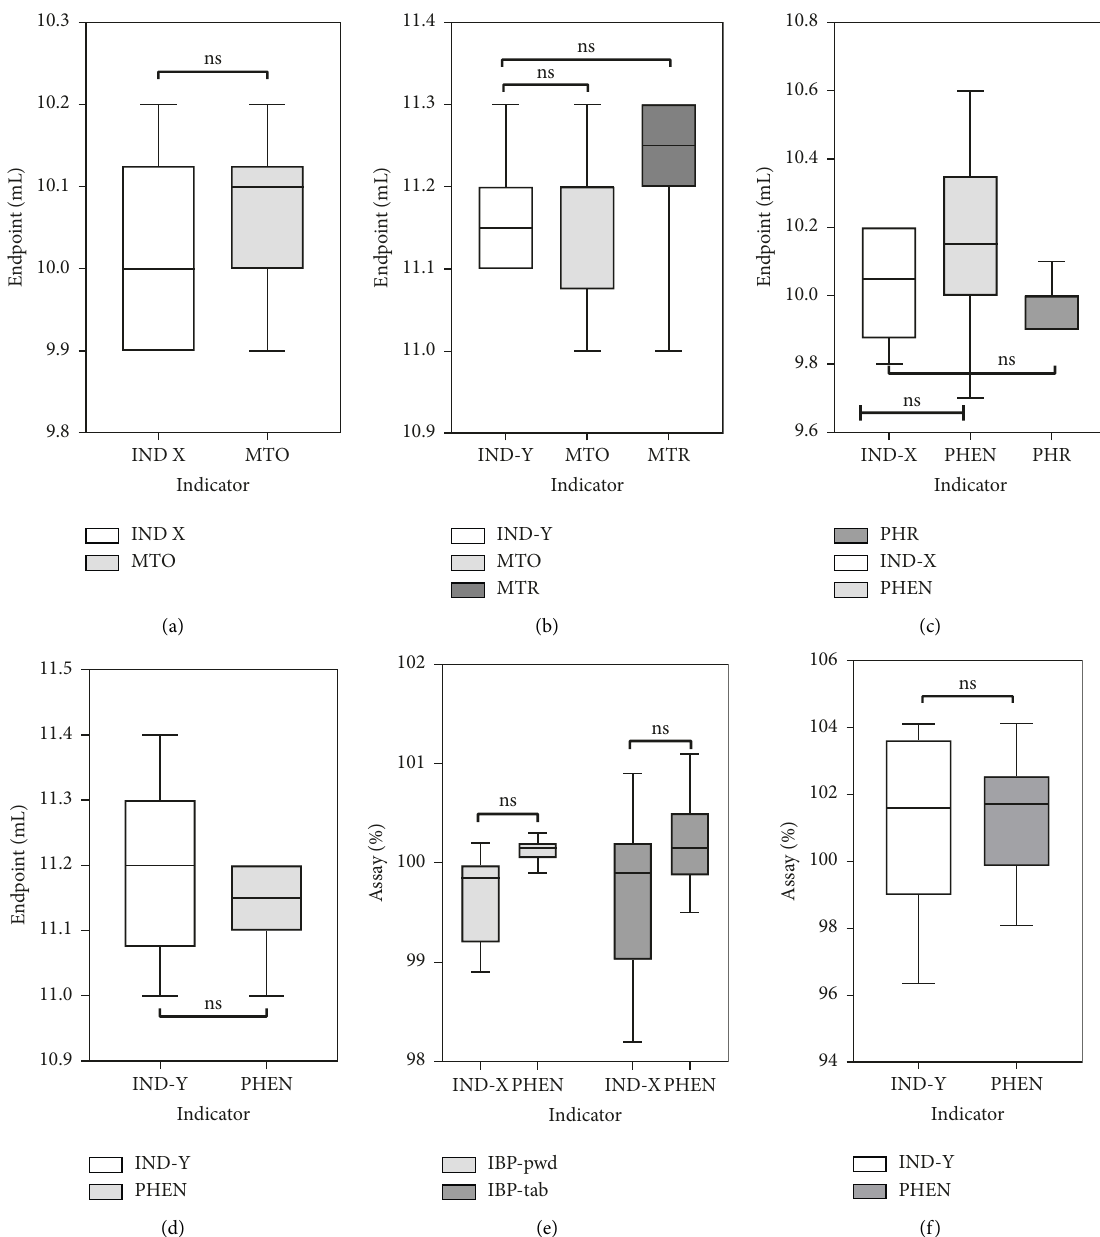
Figure 5: Accuracy investigations involving IND-X and IND-Y. (a) Comparing results from the use of IND-X with methyl orange (MTO) in HCl/NaOH titrations ( n � 10); (b) comparing results from the use of IND-Y with MTO and methyl red (MTR) in HCl/NaOH titrations ( n � 10); (c) comparing results from the use of IND-X with phenolphthalein (PHEN) and phenol red (PHR) in CH 3 COOH/NaOH titrations ( n � 10); (d) comparing results from the use of IND-Y with phenolphthalein (PHEN) in CH 3 COOH/NaOH titrations ( n � 10); (e) comparing results from the use of IND-X with phenolphthalein (PHEN) in the titrimetric assay of ibuprofen powder (IBP-PWD) and ibuprofen tablets (IBP-tab) ( n � 10); (f) comparing results from the use of IND-Y with phenolphthalein (PHEN) in the titrimetric assay of ibuprofen